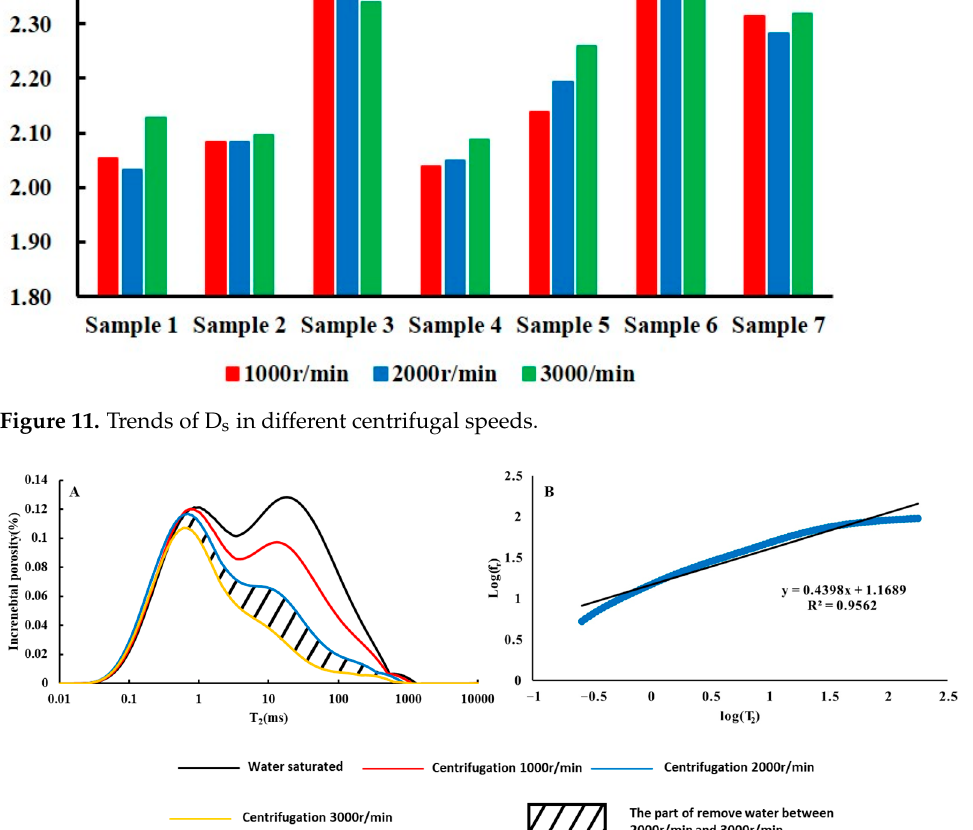
Table 6. Fractal Dimensions of the residual water from NMR in different centrifugal speeds.